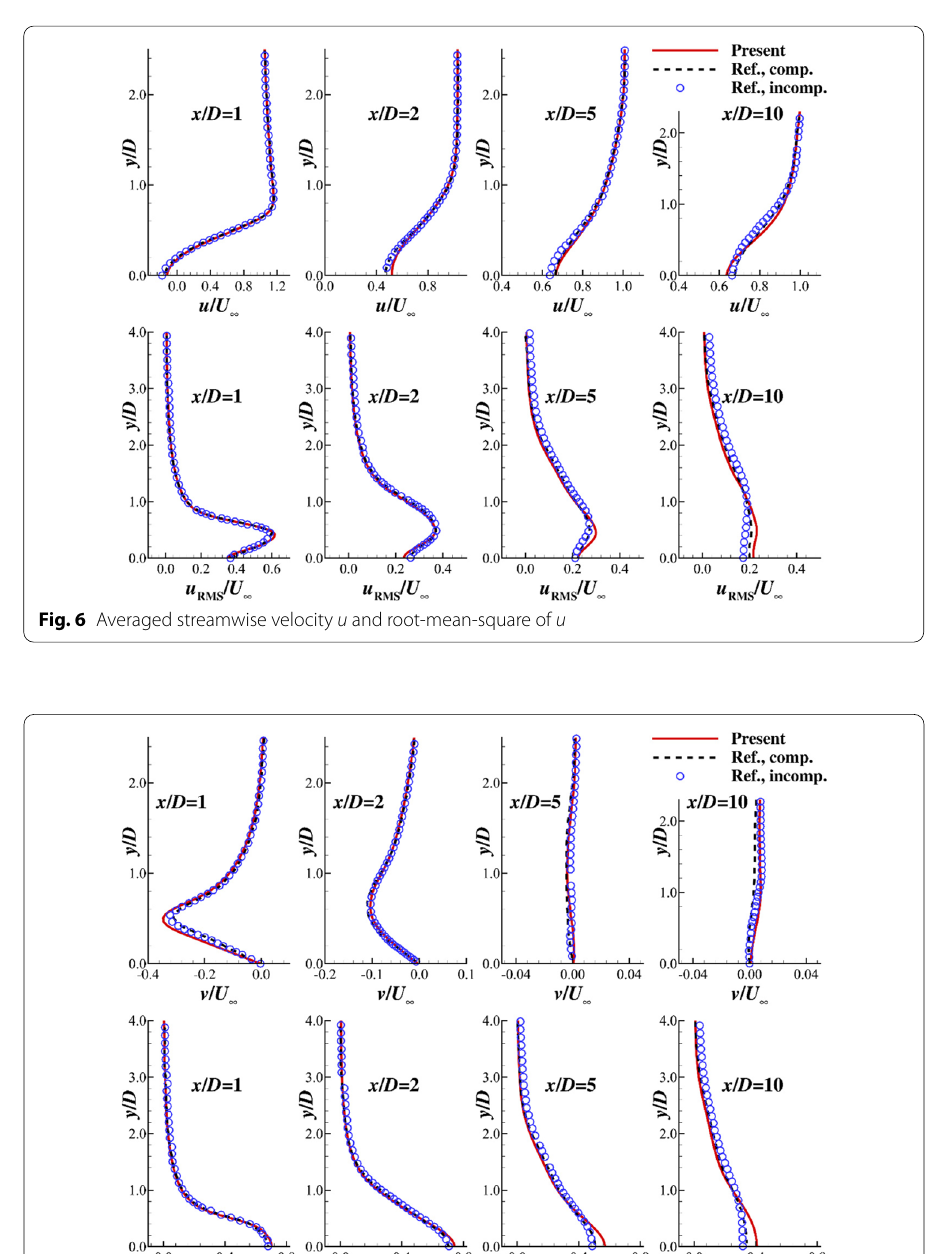
vortex cores were surrounded by turbulent structures. With the present low-dissipation numerical scheme and fine-tuned computation grid, the vortex strength in the wake was well resolved and persisted for a long distance. The mean flow field was obtained by averaging 200 time units. Figures 6 and 7 show comparisons of the averaged velocity components u and v and the root-mean-square (RMS) of u and v at four streamwise locations. The dashed lines and symbols represent